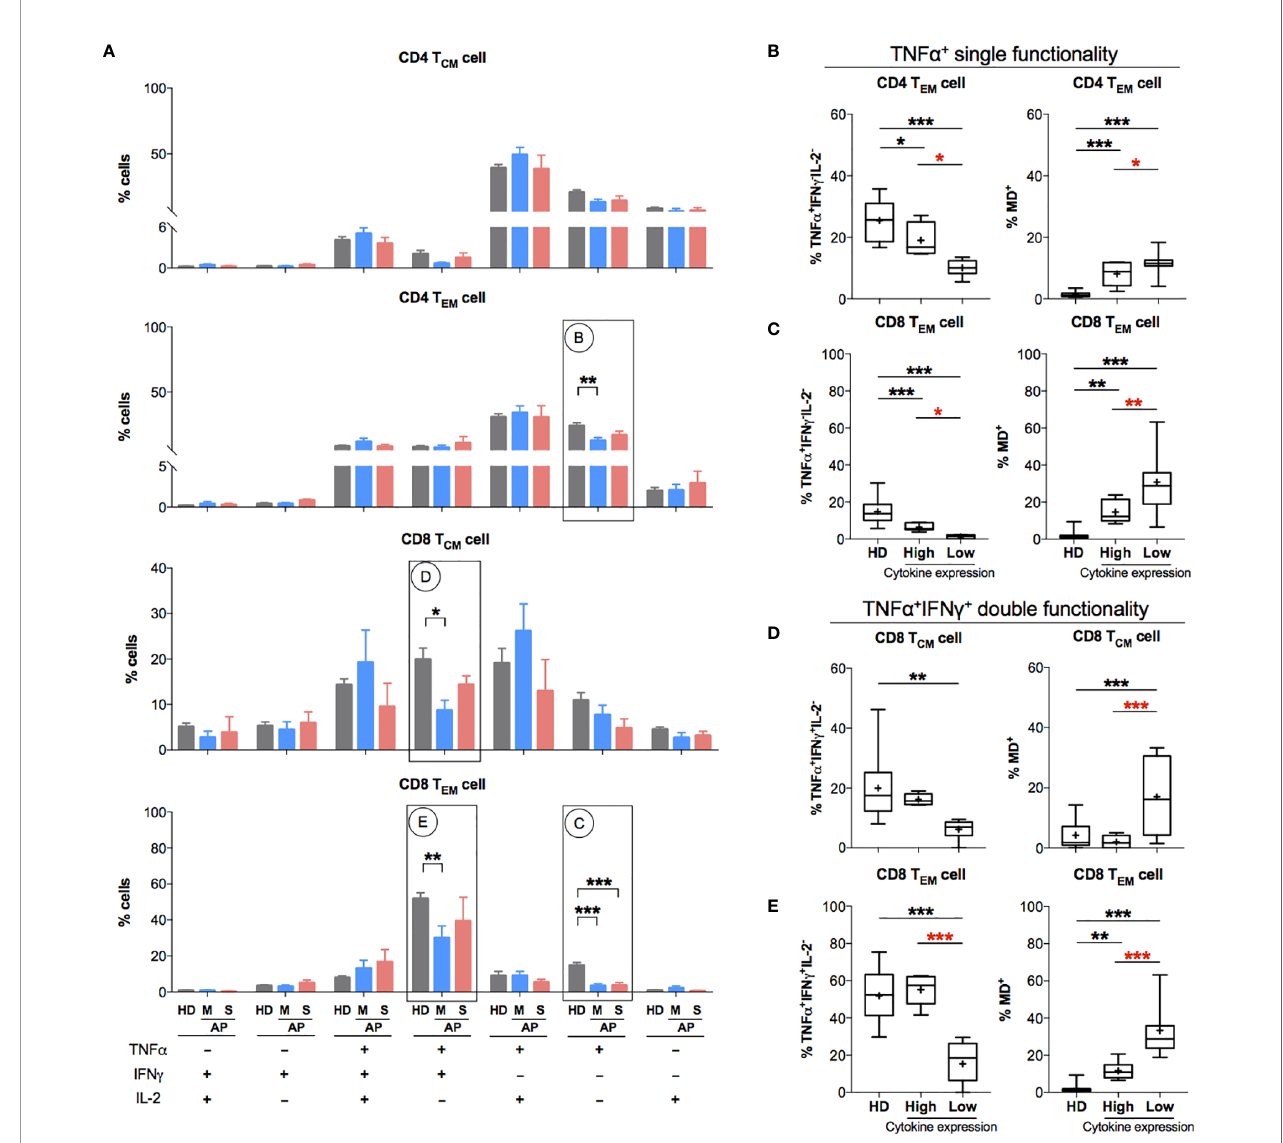
FIGURE 5 | Patients with impaired functionality in effector memory T cells have high MD + proportion. In order to understand the relationship between cells with mitochondrial dysfunction (MD + ) and phorbol 12-myristate-13-acetate (PMA)-stimulated T-cell responses in COVID-19 patients at the later stage of infection, 13 SARS-CoV-2 acute patients [APs; 8 mild (M) and 5 severe (S) on Day 11 – 15 post symptom onset (p.s.o.)] and 18 healthy donors (HDs) were collected for polyfunctional analysis in at least three independent experiments. Fresh peripheral blood mononuclear cells (PBMCs) from these 13 recruited APs were treated with PMA/ionomycin in the presence of brefeldin A (BFA) for 6 h. PBMCs from 18 HDs served as control. Cells were then harvested for FACS analysis on intracellular expression of TNF a , IFN g , and IL-2. BFA-treated only cells served as negative control. (A) The percentages of TNF a +/- IFN g +/- IL2 +/- cells in CD4 T CM , CD4 T EM , CD8 T CM , and CD8 T EM cells were displayed in bar charts. The groups of TNF a +/- IFN g +/- IL2 +/- cells [labeled with (B – E) in cycle] with signi fi cant changes in APs were selected for further comparison as shown in the corresponding fi gures (B – E) . The percentage of certain cytokine expression groups and pro fi le of MD + proportion in CD4 T EM , CD8 T CM , and CD8 T EM cells were compared between patients with highly cytokine-expressed cells (higher than median) and those with impaired cytokine-expressed cells (not higher than median). Data represent mean ± SEM. Statistics were calculated based on one-way ANOVA test. * p < 0.05, ** p < 0.01, *** p <